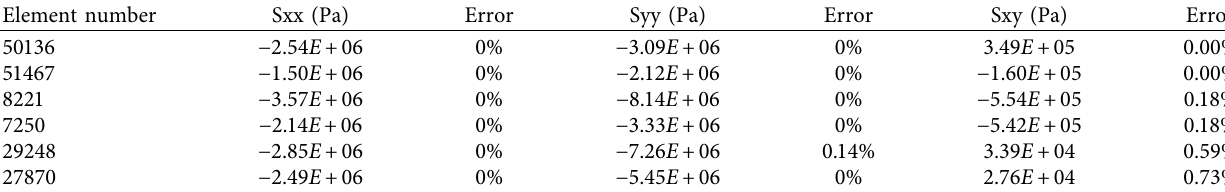
Table 5: The calculated stress in measured points by full order model.